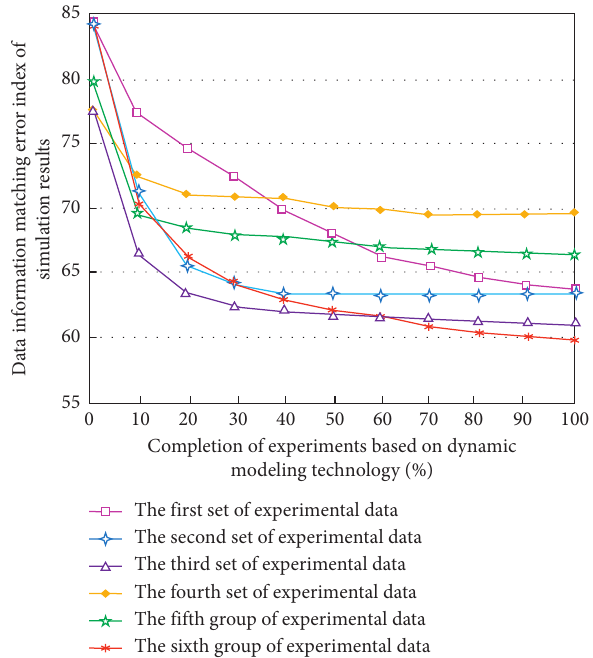
Figure 7: Preliminary experimental results of the improved value evaluation model on 6 sets of experimental